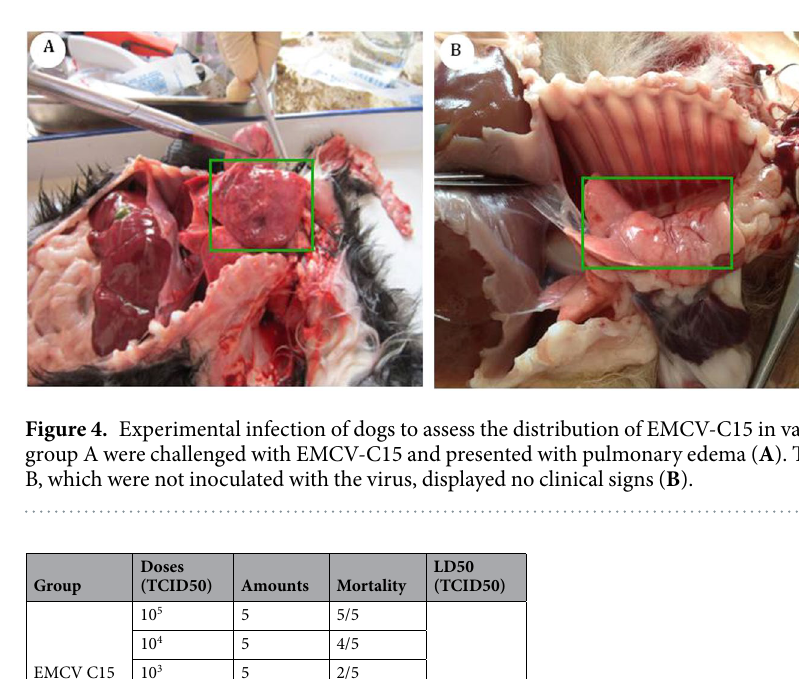
Figure 3. Western blot analysis. BHK21 cells were infected at an MOI of 1.0 for 48 h. The total cell extracts from uninfected and infected cells were analyzed by western blotting using a mouse anti-EMCV VP1 monoclonal antibody. The same blots were reprobed with mouse anti-GAPDH antibody. Molecular size markers are indicated to the left of each blot.